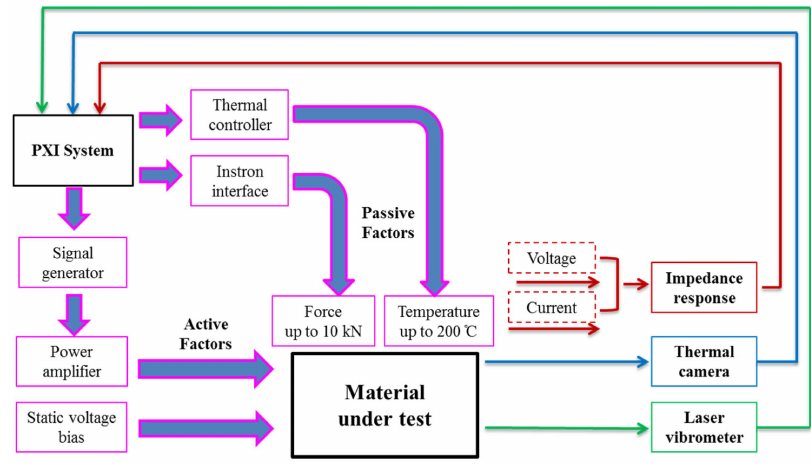
Figure 2. Piezoelectric functional characterisation system